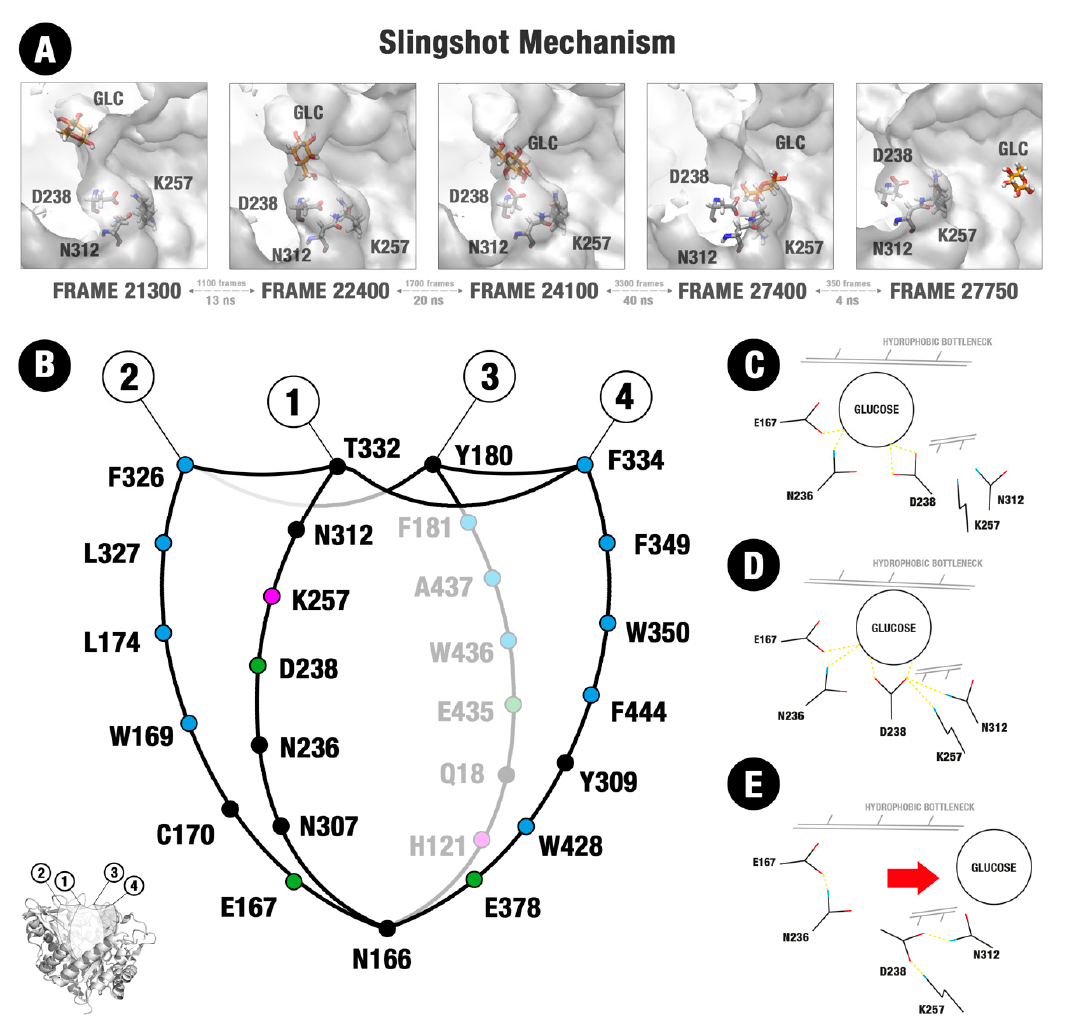
Figure 6. Structure of the substrate channel of HiGB and the mechanism of glucose release. ( A ) Five snapshots of the MD simulation that illustrate the slingshot mechanism and residues involved. ( B ) Structure of the substrate channel organized into four sectors (1–4). A set of hydrophobic residues is located in the entrance of this channel, mainly in the sectors 2, 3, and 4. Circles represent apolar (blue), polar neutral (black), polar positively charged (magenta), and polar negatively charged (green) amino acids. ( C – E ) Amino acid residues involved in the slingshot mechanism: E167, N236, D238, K257, and N312.